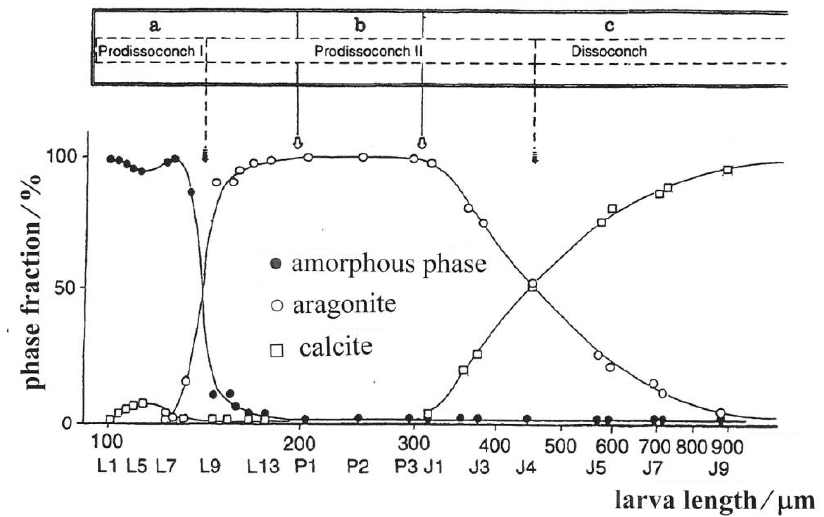
Figure 5. Variation of the fractions of amorphous tissue, aragonite, and calcite with the development stage in Ostrea edulis : multi-cell embryo (samples L1–L3), trochophore (L4, L5), early veliger (L6, L7), veliger / prodissoconch I (L8), veliger / prodissoconch I / II (L9), grey-black phase / prodissoconch II (L11, L12), black phase / prodissoconch II (L13), pediveliger / plankton (P1–P3), postsettlement / metamorphosis (J1, J2), prodissoconch II / dissoconch (J3), dissoconch (J4–J9) [21].